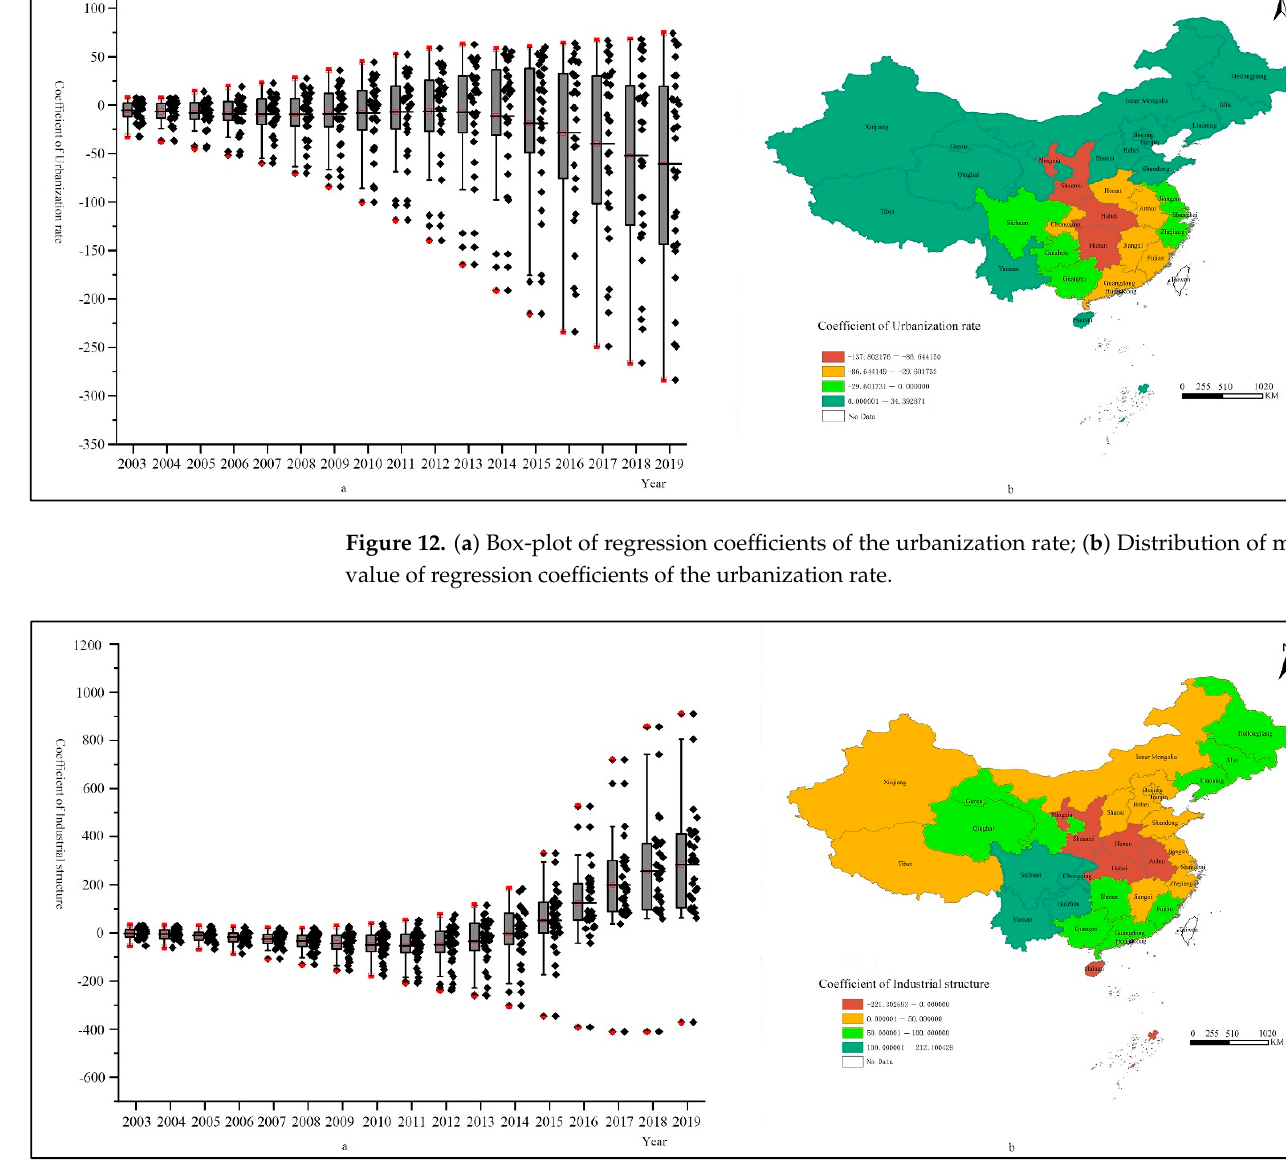
Figure 12. ( a ) Box-plot of regression coefficients of the urbanization rate; ( b ) Distribution of mean value of regression coefficients of the urbanization rate.